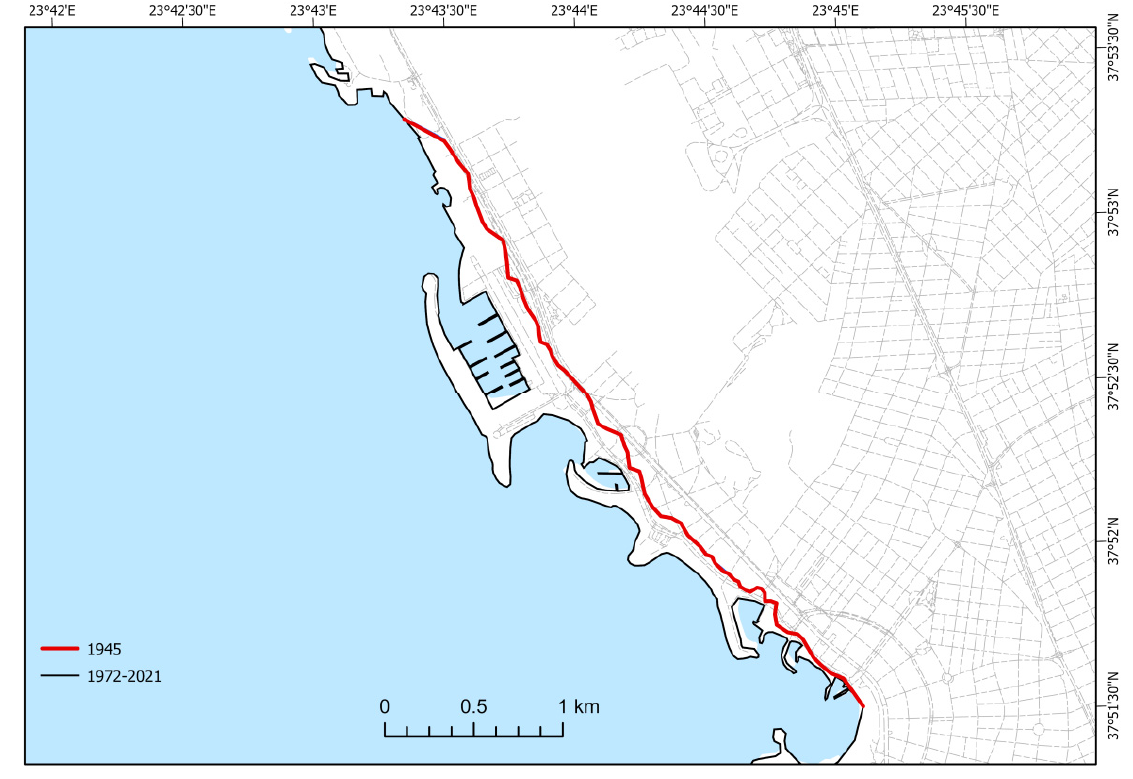
Figure 6. The coastlines of Glyfada from 1945 to 2021.